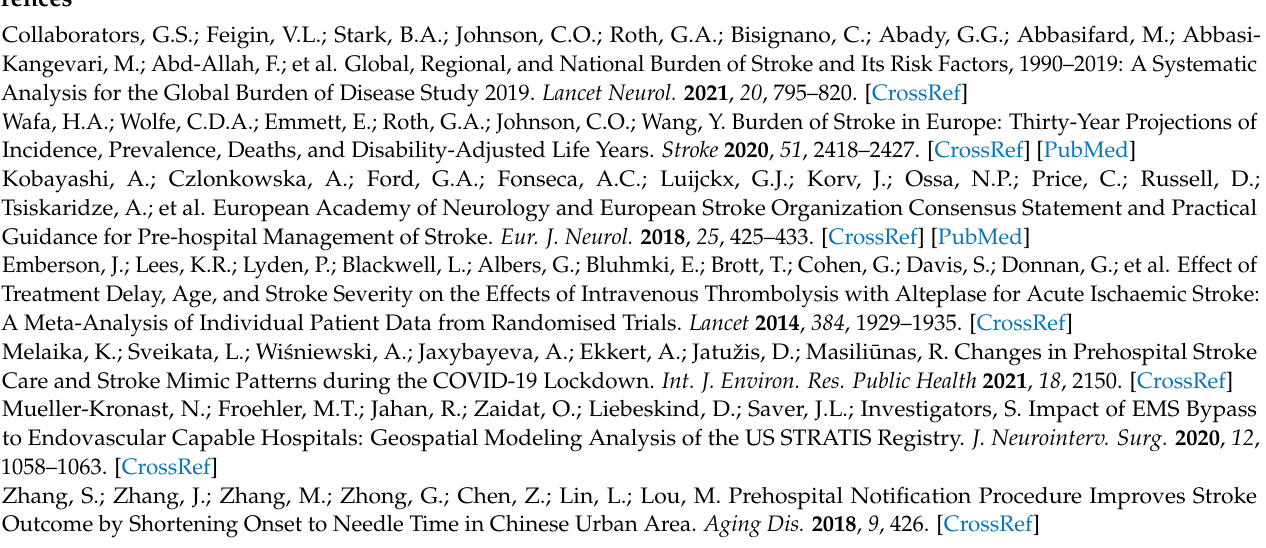
Figure S2: EMS self-reported need for continuous professional development in Vilnius city and dis- tricts; Figure S3: EMS staff’s evaluation of how prehospital care impacts patient-related outcomes; Figure S4: EMS received feedback on stroke patients; Figure S5: EMS attitude on current Lithuanian stroke care